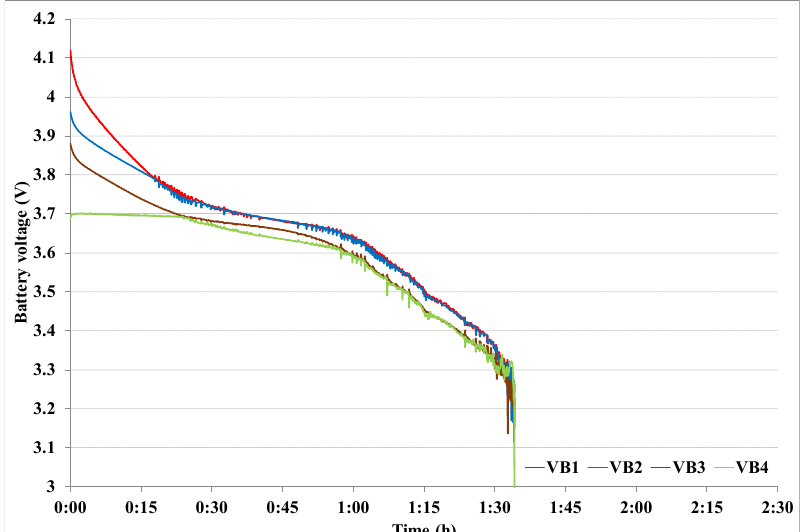
Figure 11. The balancing curves of battery voltage while discharging.